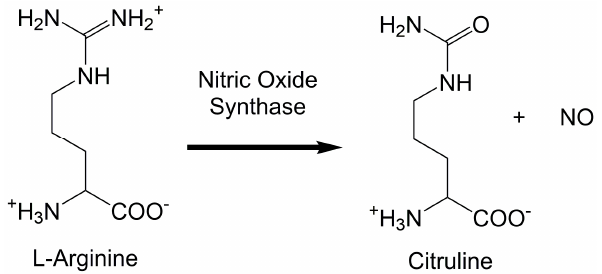
Figure 3. The nitric oxide synthase (NOS) system can be probed to approximate the concentration of nitric oxide (NO) being produced [61,66].